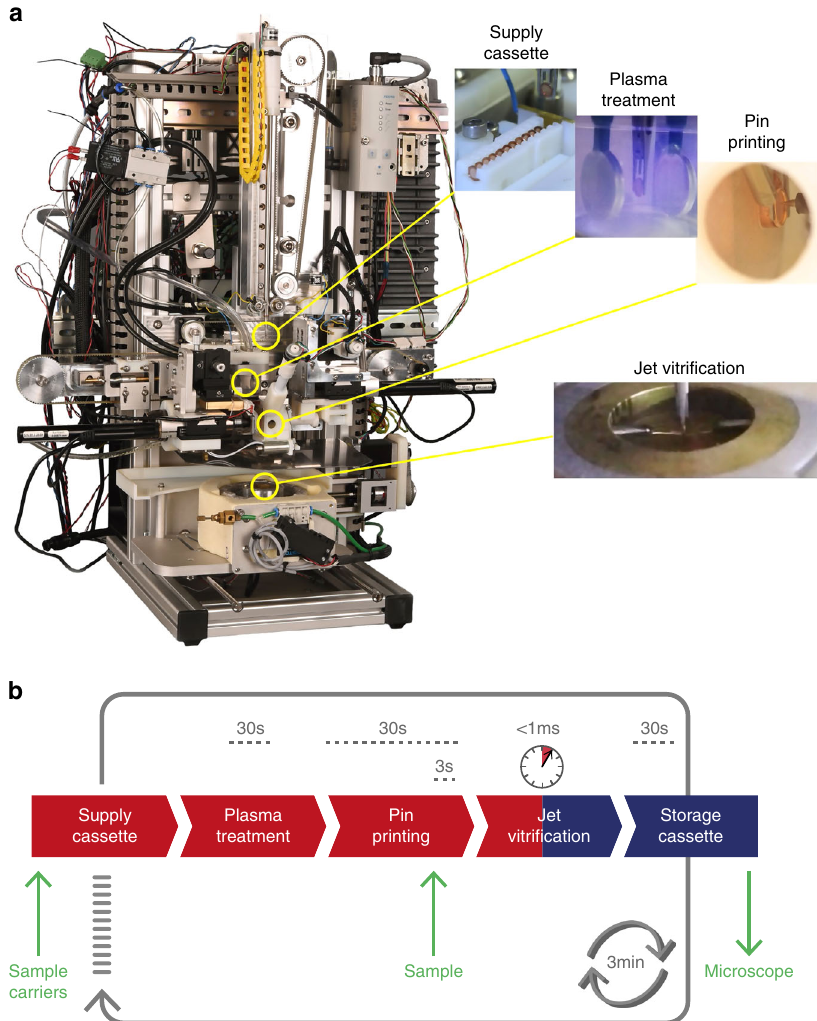
Fig. 3 The VitroJet work fl ow. a The device and b the work fl ow. Sample carriers (up to 12) are introduced in a supply cassette and sample (up to 0.5 µ l) in a pipette tip (yellow arrows). The VitroJet automatically processes the cassette by sequentially passing sample carriers through the plasma treatment, sample deposition by pin printing, jet vitri fi cation and fi nally storing the grid in a cryogenic cassette ready to enter the electron microscope (green arrow). The supply cassette is at room temperature (red), the storage cassette at cryogenic temperature (blue). An animation showing all subsequent steps is shown in Supplementary Movie